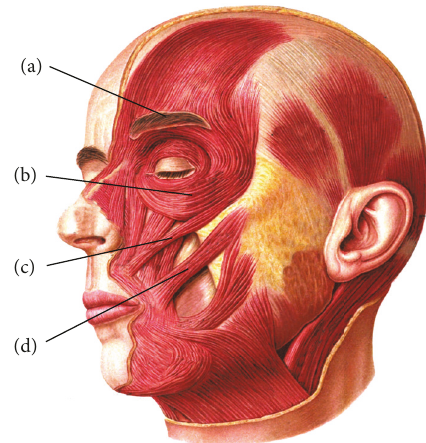
Figure 1: Facial muscles. (a) Corrugator supercilii. (b) Orbicularis oculi. (c) Zygomaticus minor. (d) Zygomaticus major. Adapted from “Sobotta’s Atlas and Text-book of Human Anatomy,” by Dr. Sobotta (Illustration: Hajek and Schmitson), 1909, in the public domain [35].